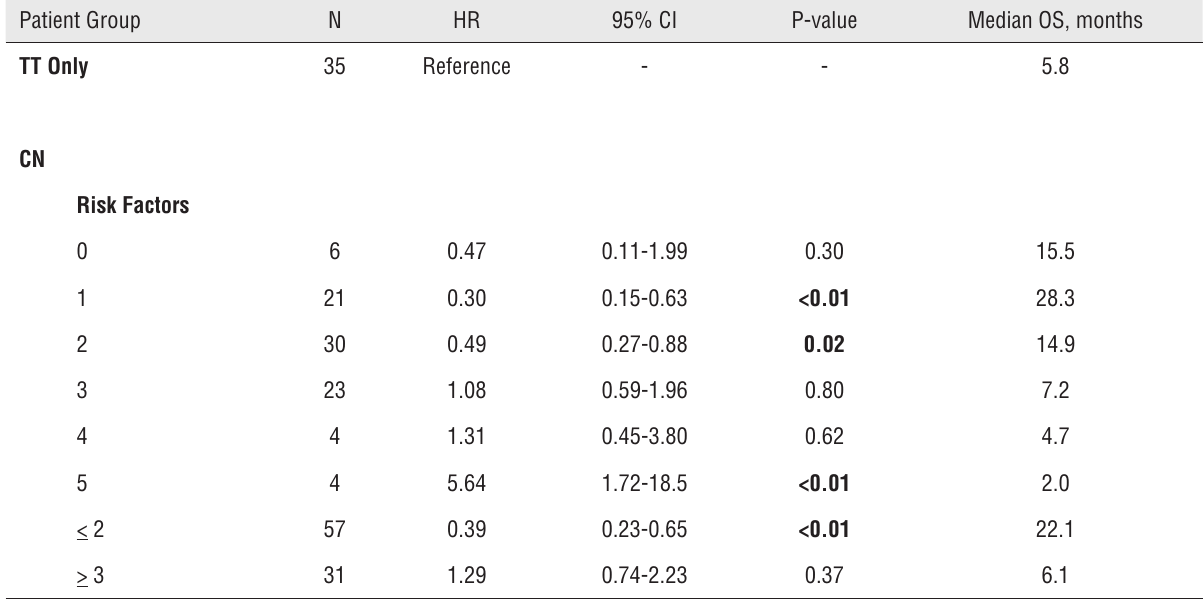
Table 2 - Median overall survival for cn patients stratified by risk factor group versus TT only.